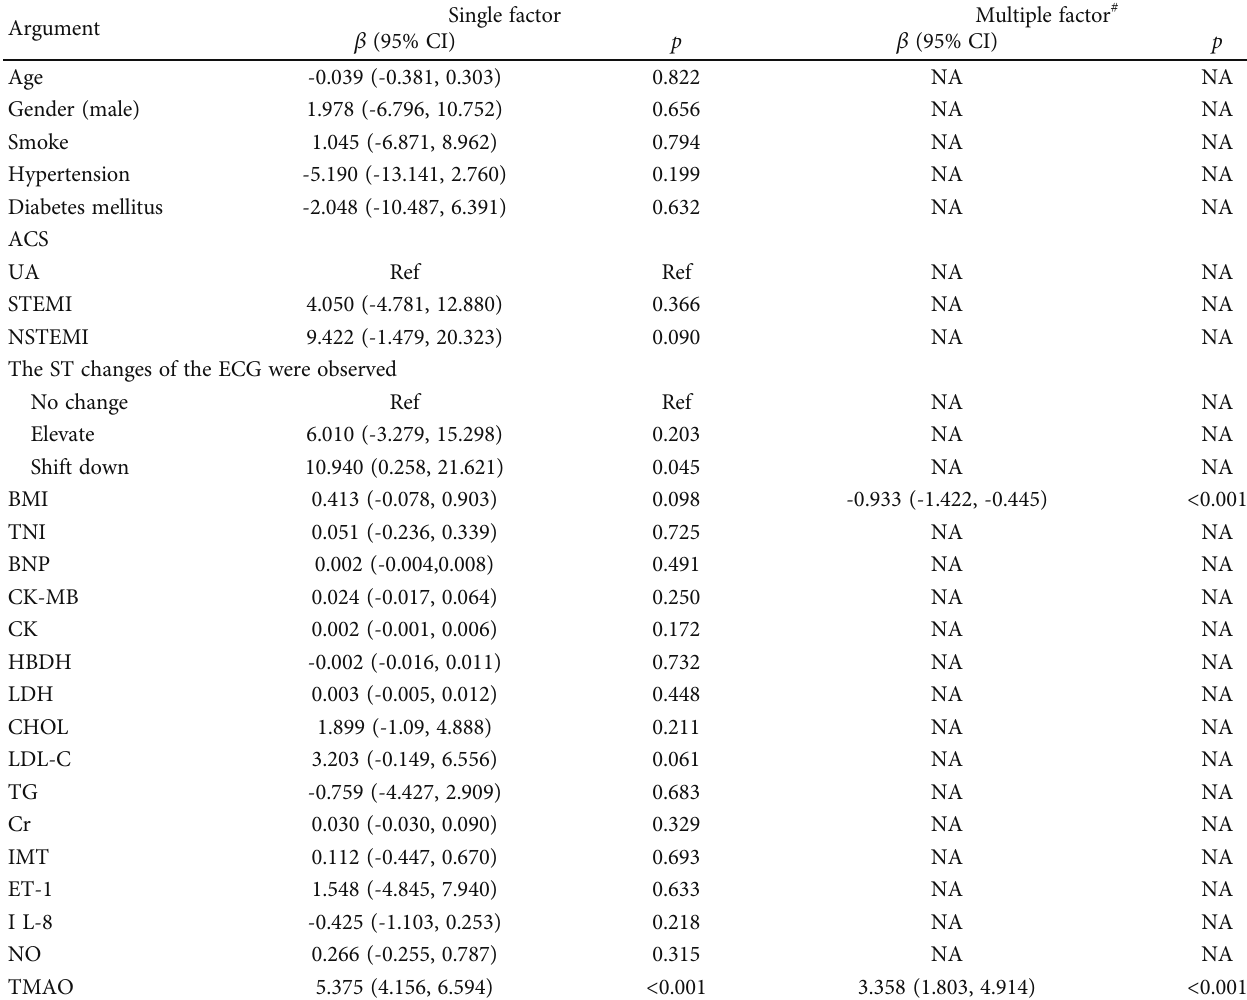
Table 3: Linear regression analysis of the Gensini